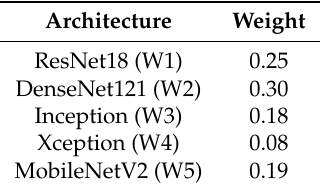
Table 5. Weight value (belief or trust value) corresponding to every